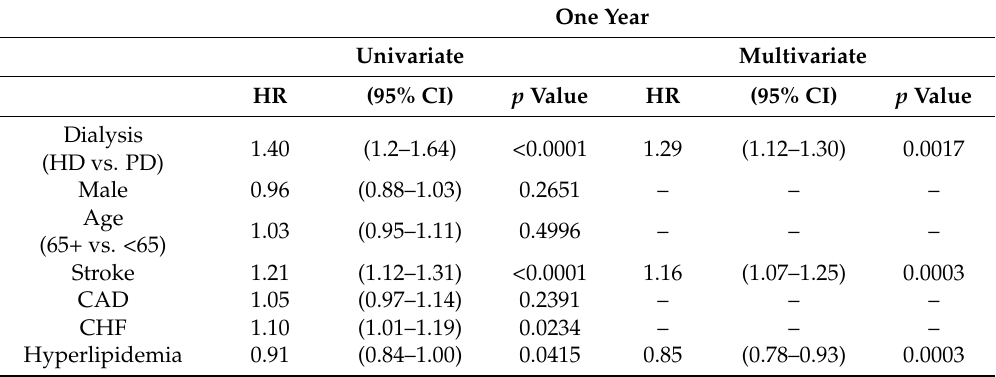
Table 2. Risk factors of one-year severe hypoglycemia among advanced diabetic kidney patients transitioning to